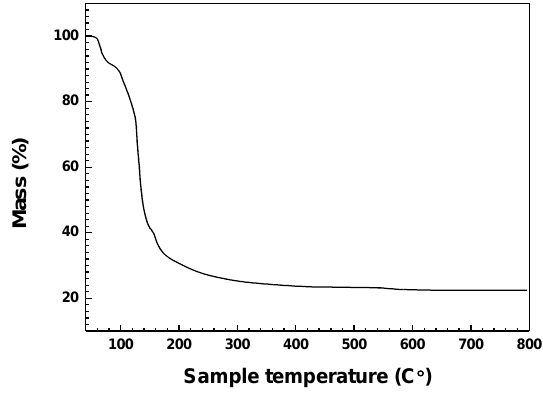
Figure 3. TGA (thermogravimetric analysis) of Ga(NO 3 ) 3 ∙ x H 2 O raw material.